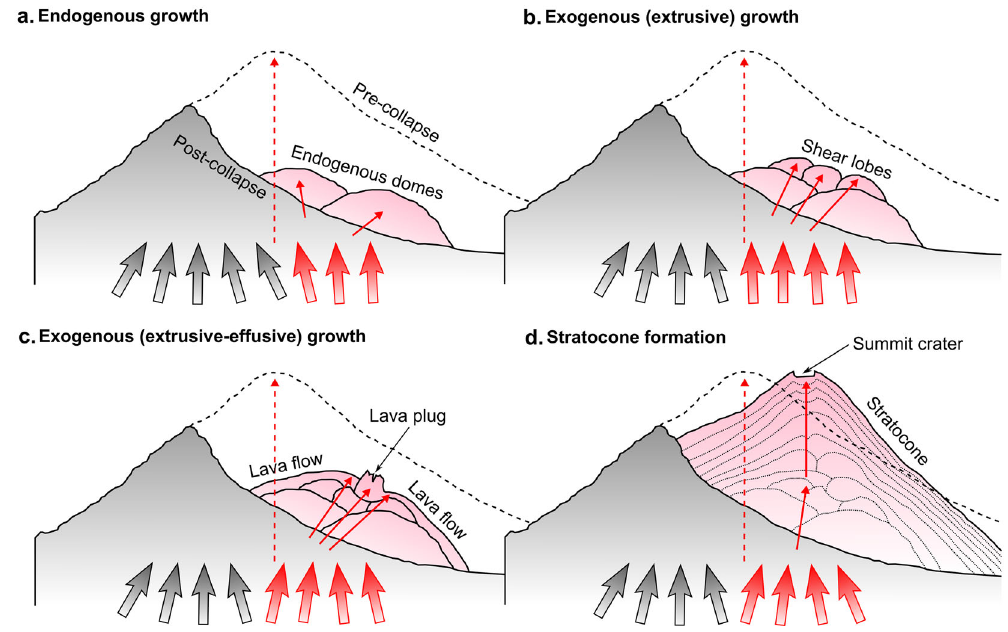
Fig. 8 Main stages of Bezymianny regrowth. a 1956 – 1967 endogenous growth of two lava domes. b 1967 – 1976 exogenous dome growth through shear lobes extrusion. c 1977 – 2006 exogenous dome growth through shear lobes and lava plugs extrusion, and lava fl ows effusion. d 2006 — present: stratocone formation through interbedding deposition of lava fl ows and pyroclastic